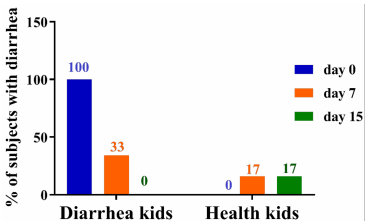
Figure 1. Effect of the administration of Bacillus amyloliquefaciens-9 on the occurrence of diarrhea in kids with diarrhea ( n = 6) and healthy kids ( n = 6).